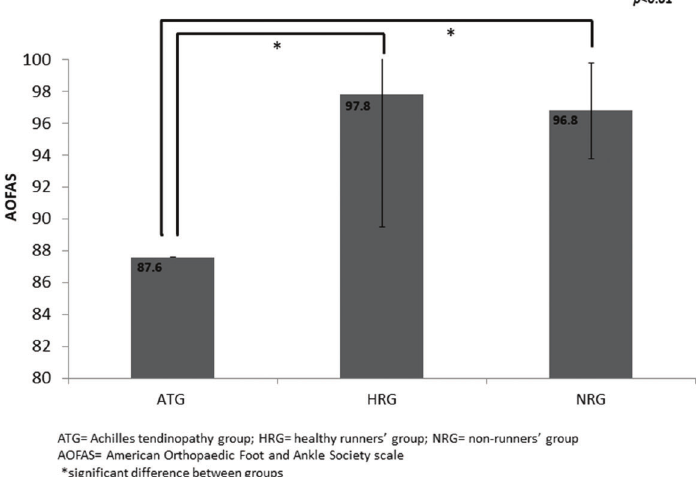
Figure 1 - Mean (standard deviation) of American Orthopedic Foot and Ankle Society scale scores in the Achilles tendinopathy group, healthy runners ’ group, and non-runners ’ group.